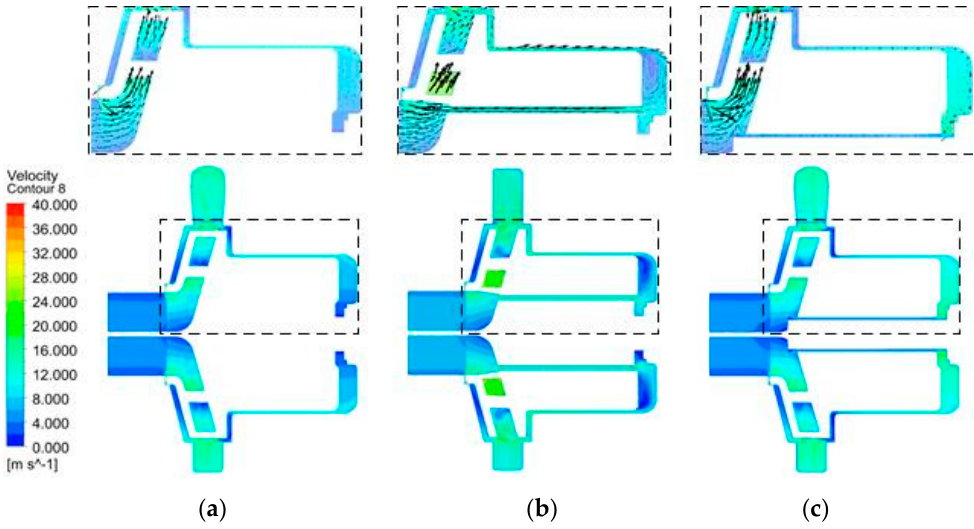
Figure 8. Comparison of the X – Z plane velocity vector and contour of the pump without balancing holes and pumps with six Type A and B balancing holes of 4 mm diameter: ( a ) without balancing holes; ( b ) with Type A balancing holes; ( c ) with Type B balancing holes.